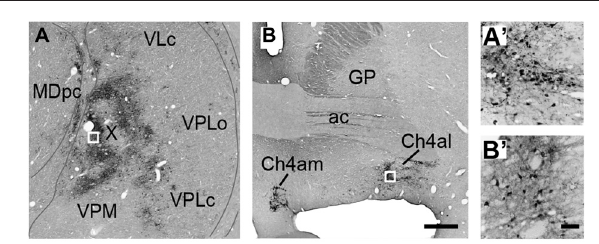
FIGURE 2 | Photomicrographs of coronal sections through the thalamus (A) and the basal forebrain (B) in Case 1. Retrograde neuron labeling 3 days after the rabies injections into PMv. Boxed areas in (A,B) are enlarged in (A (cid:48) ,B (cid:48) ) , respectively. Scale bars in (B,B (cid:48) ) , 1 mm for (A,B) , and 100 µ m for (A (cid:48) ,B (cid:48) ) . ac, anterior commissure; Ch4al, antero-lateral territory of the cholinergic cell group 4; Ch4am, antero-medial territory of the cholinergic cell group 4; GP, globus pallidus; MDpc, parvocellular division of the mediodorsal thalamic nucleus; VLc, caudal division of the ventrolateral thalamic nucleus; VPLc, caudal division of the ventroposterolateral thalamic nucleus; VPLo, oral division of the ventroposterolateral thalamic nucleus; VPM, ventroposteromedial thalamic nucleus; X, area